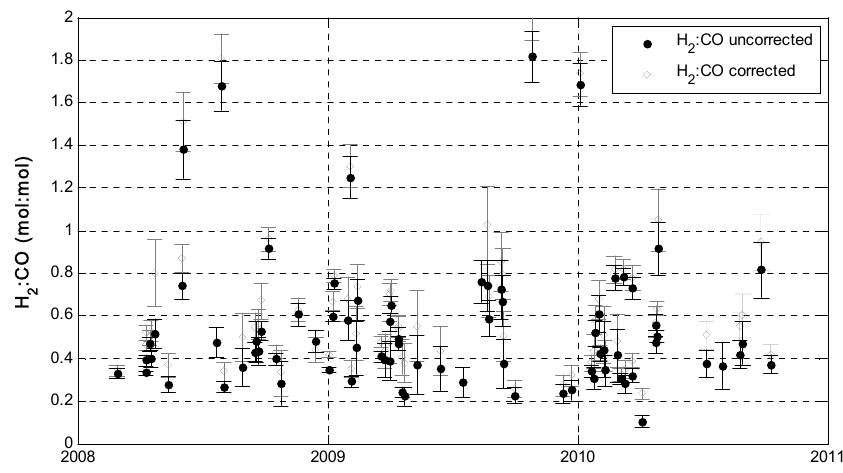
Fig. 9. Molar H 2 /CO ratios from morning rush hour data. For comparison, the data before and after the H 2 soil uptake correction are shown.